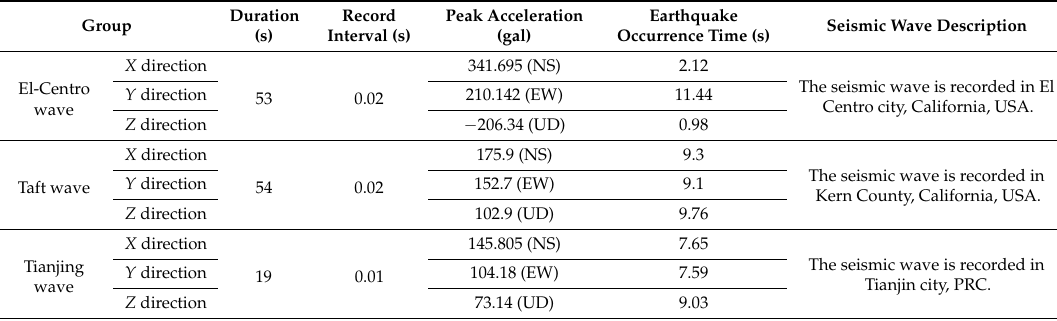
Table 3. Earthquake waves table in the experiment.